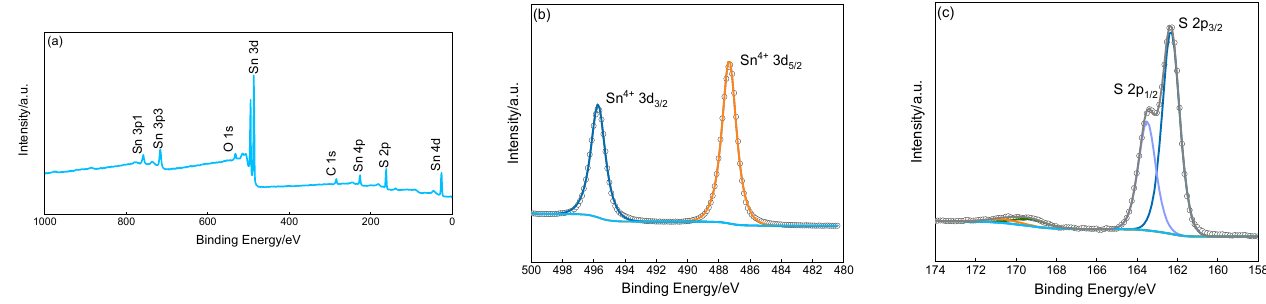
Figure 3. XPS characterization of nano-SnS 2; ( a ) full-spectrum scan results of nano-SnS 2; ( b ) Sn element spectrum; ( c ) S element spectrum.